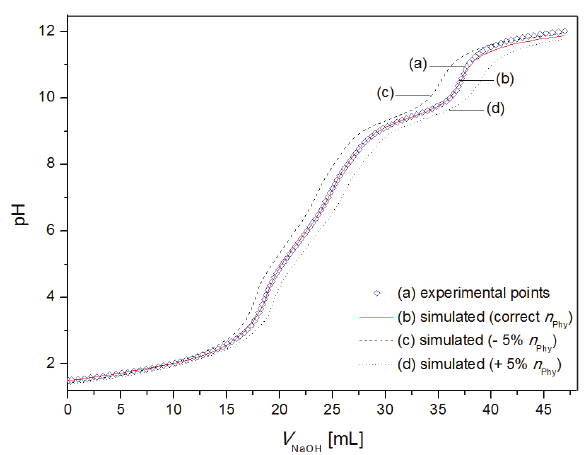
Figure 5. Titration of 0.3081 mmol H Phy with 0.0996 M NaOH 12 in 1.0 M NaCl. (a) Squares represent observed experimental points and lines represent simulated curves using (b) correct amount of phytate, (c) –5% and (d) +5% deviation in amount of total phytate. Protonation constants used for simulations (c) and (d) were same as calculated for the correct amount of phytate (curve b). Initial molar ratio between protons and phytate was set to 12.0 in all